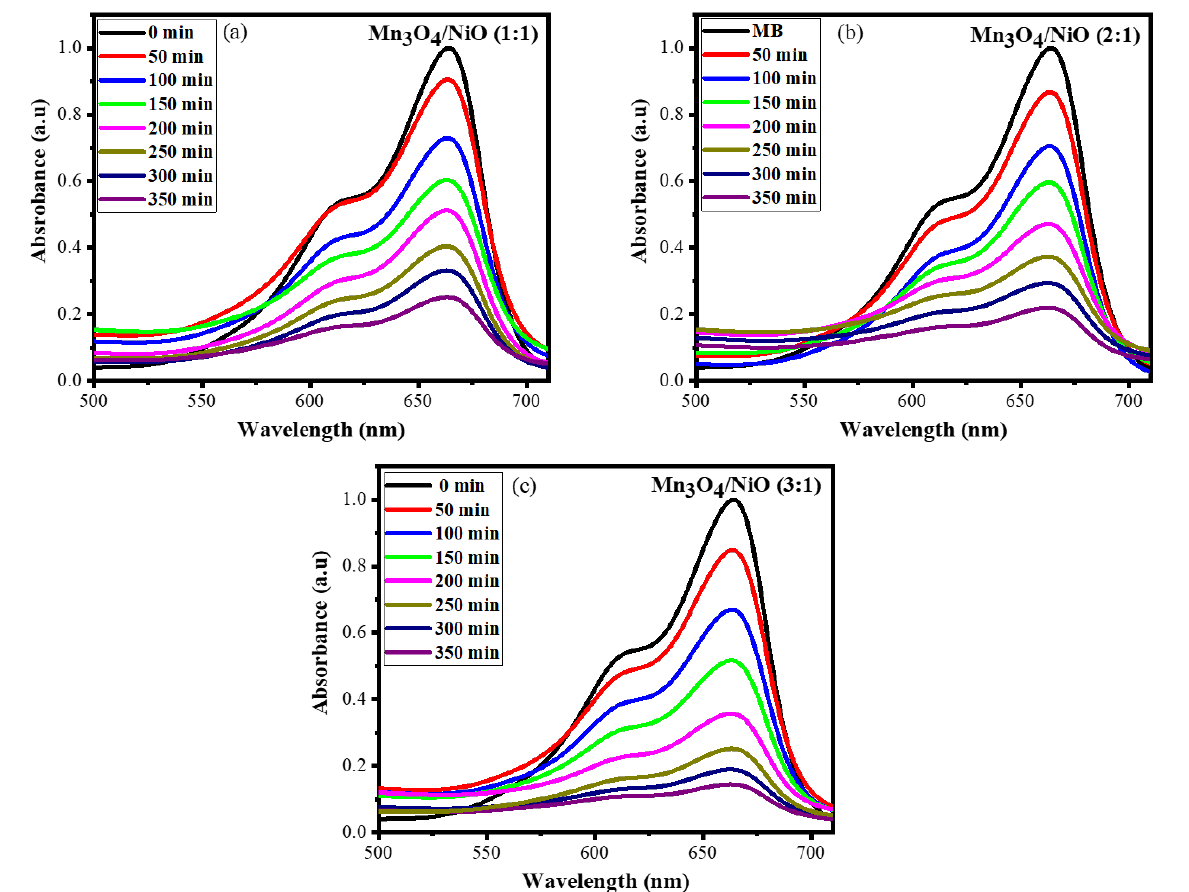
Figure 8. UV–Visible absorption spectra of the ( a ) NC Mn 3 O 4 /NiO (1:1), ( b ) NC Mn 3 O 4 /NiO (2:1), and ( c ) NC Mn 3 O 4 /NiO (3:1) under visible light at 657 and ( c ) NC Mn 3 O 4 /NiO (3:1) under visible light at 657 nm .